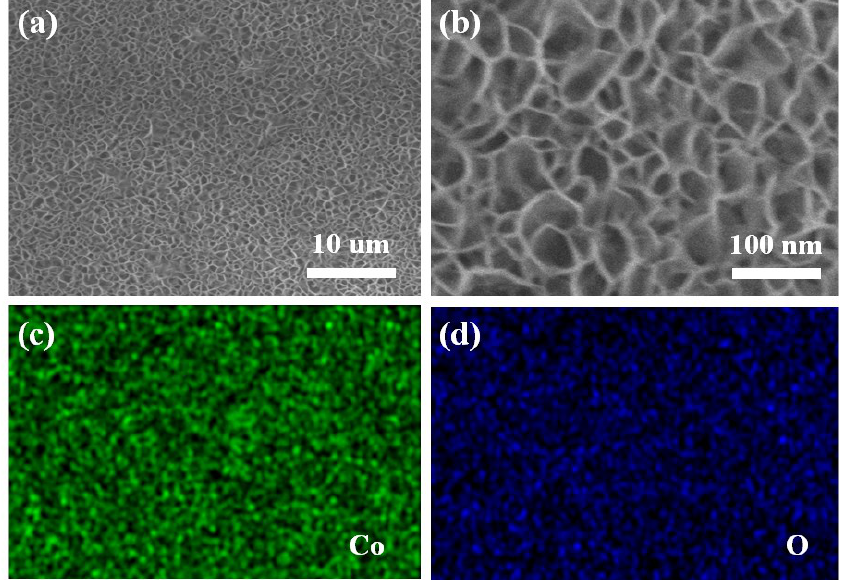
Figure 1. ( a , b ) SEM images of Co 3 O 4 at different magnifications. ( c , d ) SEM mapping images of Co and O elements, respectively.